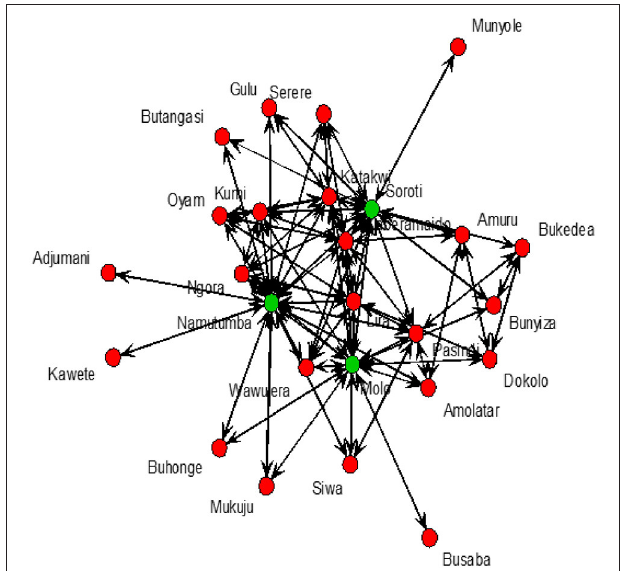
FIGURE 7 | Visualization of link communities within the cattle network (using node pies). The fraction of the total number of edges that a node has in each community is depicted using a pie chart.